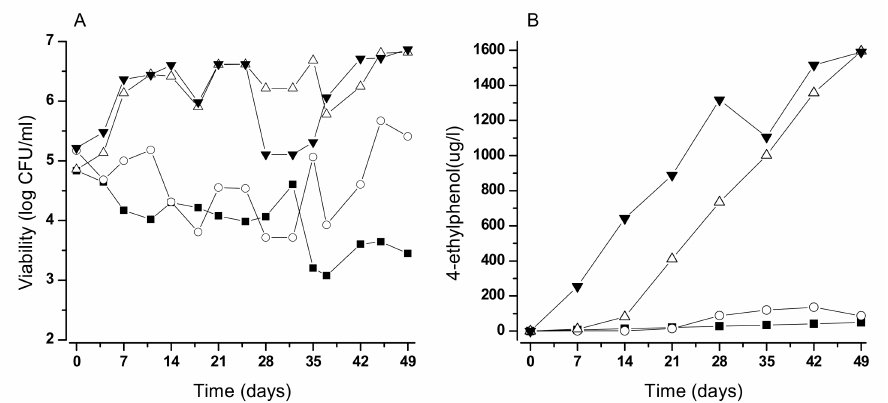
Figure 3. Growth ( A ) and 4-EP production ( B ) by B. bruxellensis under wines stored at different temperatures (symbols: (cid:4) , 3 ◦ C; , 10 ◦ C; ∆ , 15 ◦ C; (cid:72) , 20 ◦ C). Cells were inoculated in 1 L Schott flasks (cid:35) and incubated without agitation to mimic tank storage